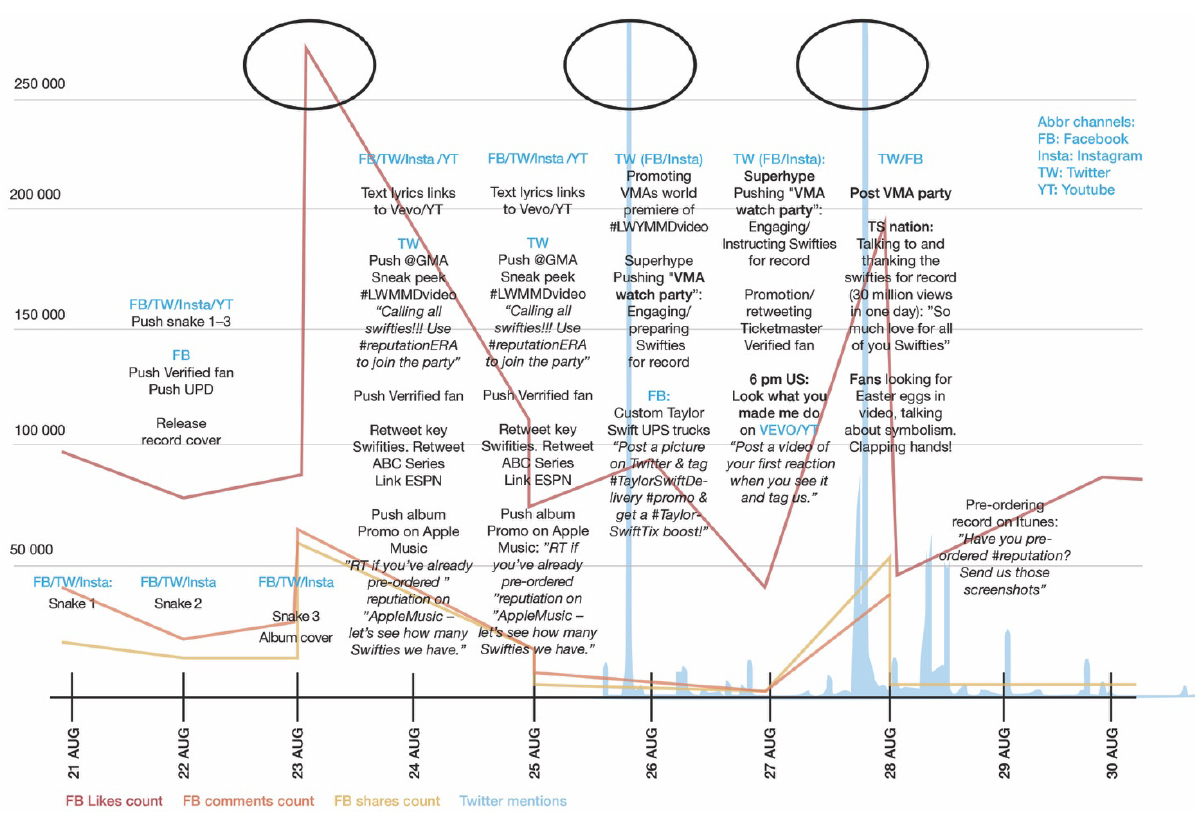
Figure 2. Example of visual layering of qualitative and quantitative data in regard to specific campaign activities and layer‐ ing data from Facebook, Twitter, Instagram, and